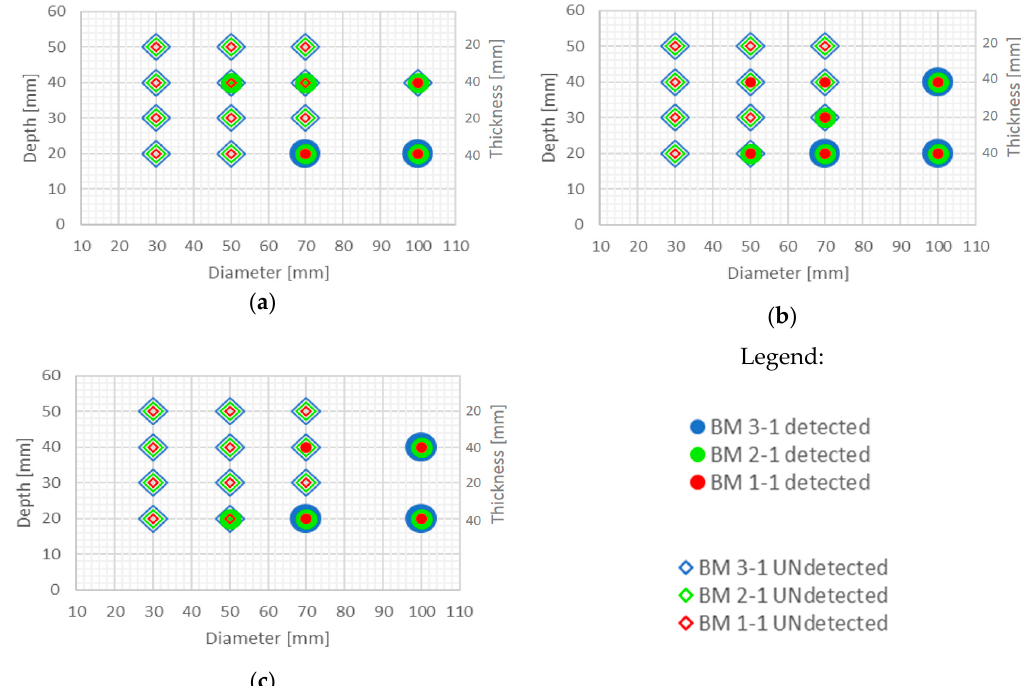
Figure 14. Possibility of defect detection overview for samples BM x-1 (all three concrete types) using optimal thermograms: ( a ) excitation distance 1.5 m; ( b ) excitation distance 2 m; ( c ) excitation distance 3 m.